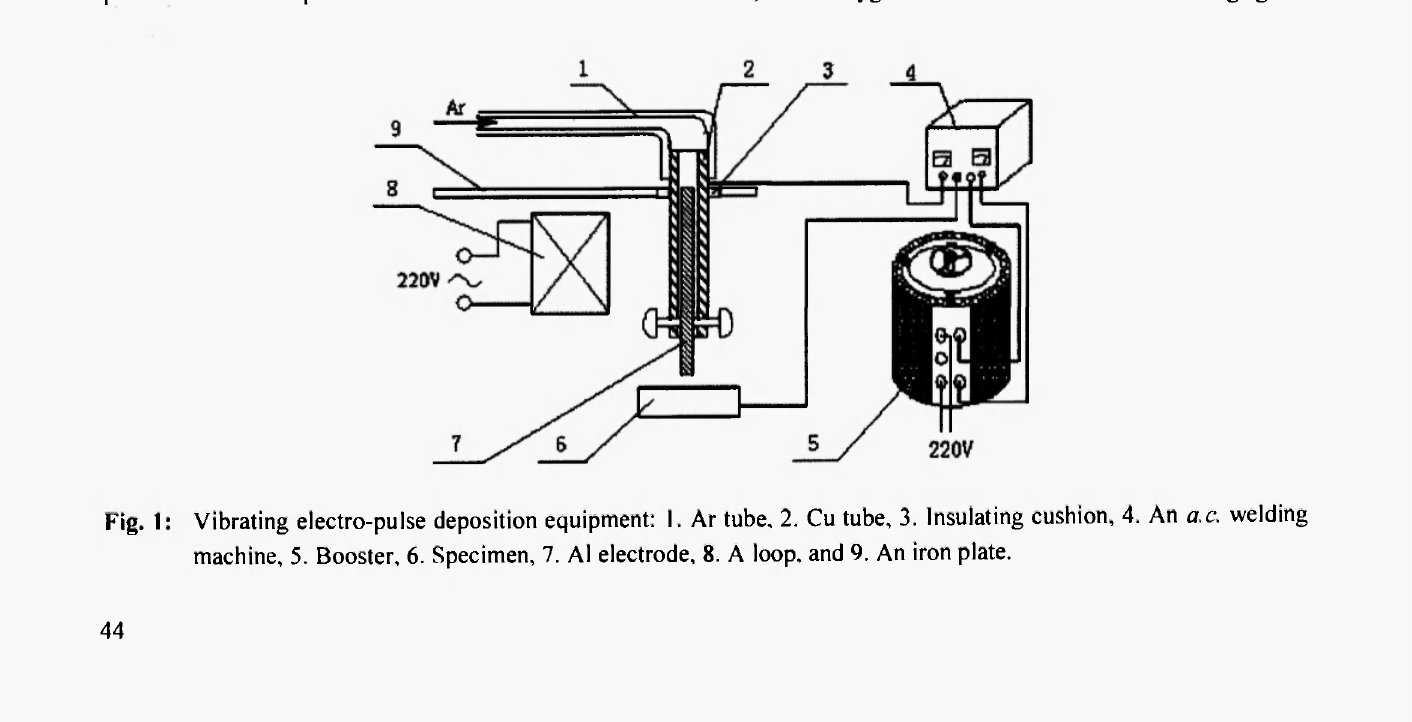
Fig. 1: Vibrating electro-pulse deposition equipment: I. Ar tube, 2. Cu tube, 3. Insulating cushion, 4. An a.c. welding machine, 5. Booster, 6. Specimen, 7. Al electrode, 8. A loop, and 9. An iron